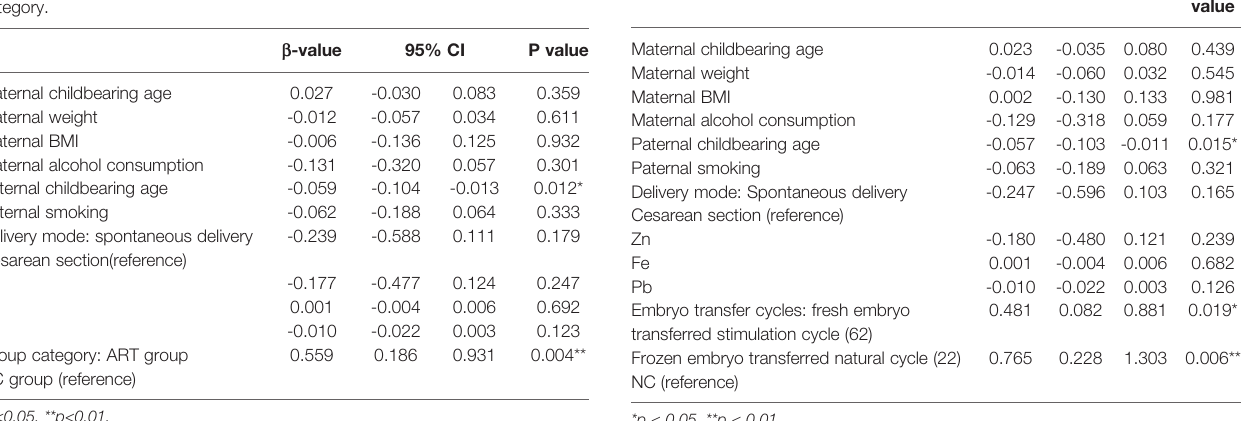
TABLE 2 | Multiple linear regression analysis of bone mineral density group category.